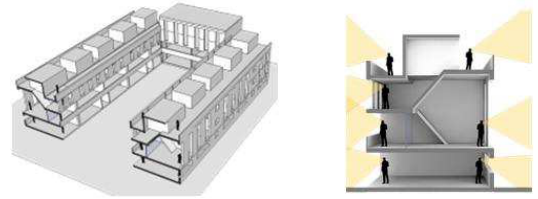
Figure 7: Second alternative schematic design: repetitive vertical duplex apartments on top of a commercial ground